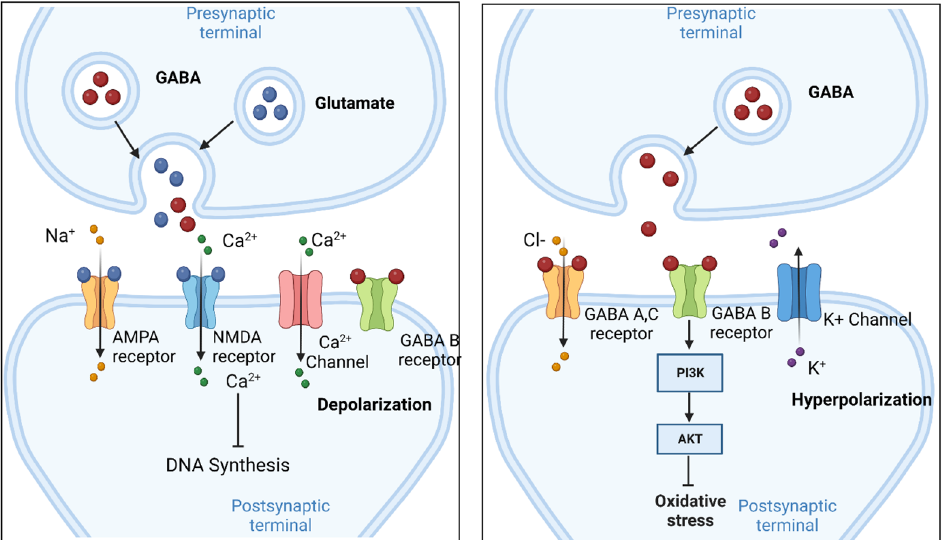
Figure 1. The role of GABA and glutamate as neurotransmitters. In the early stages of cortical neurogenesis, glutamate and GABA depolarize cells in the ventricular region of the mouse embryo neocortex (left panel). Glutamate binds its receptor, which is known as N-methyl-D-aspartate receptor (NMDA receptor or NMDAR), to depolarize the neuron. Glutamate selectively interacts with α - amino-3-hydroxy-5-methyl-4-isoxazole propionic acid (AMPA) and GABA can bind to gamma